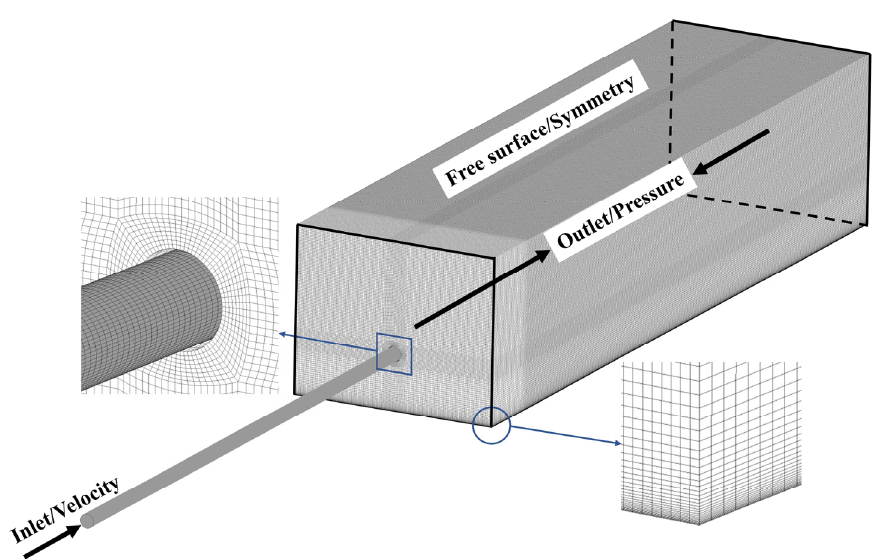
Figure 4. Schematic diagram of the computational model grid.